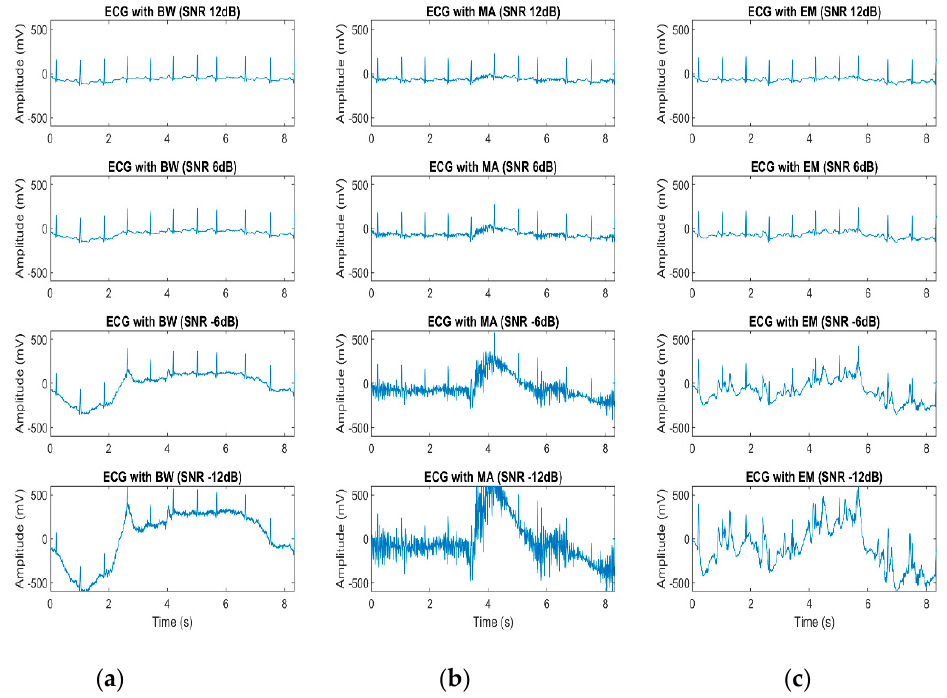
Figure 3. Example of simulated ECG signals that contain noise with signa-to-noise-ratio (SNR) 12, 6, − 6, − 12 dB: ( a ) ECG signal with BW; ( b ) ECG signal with MA; ( c ) ECG signal with EM